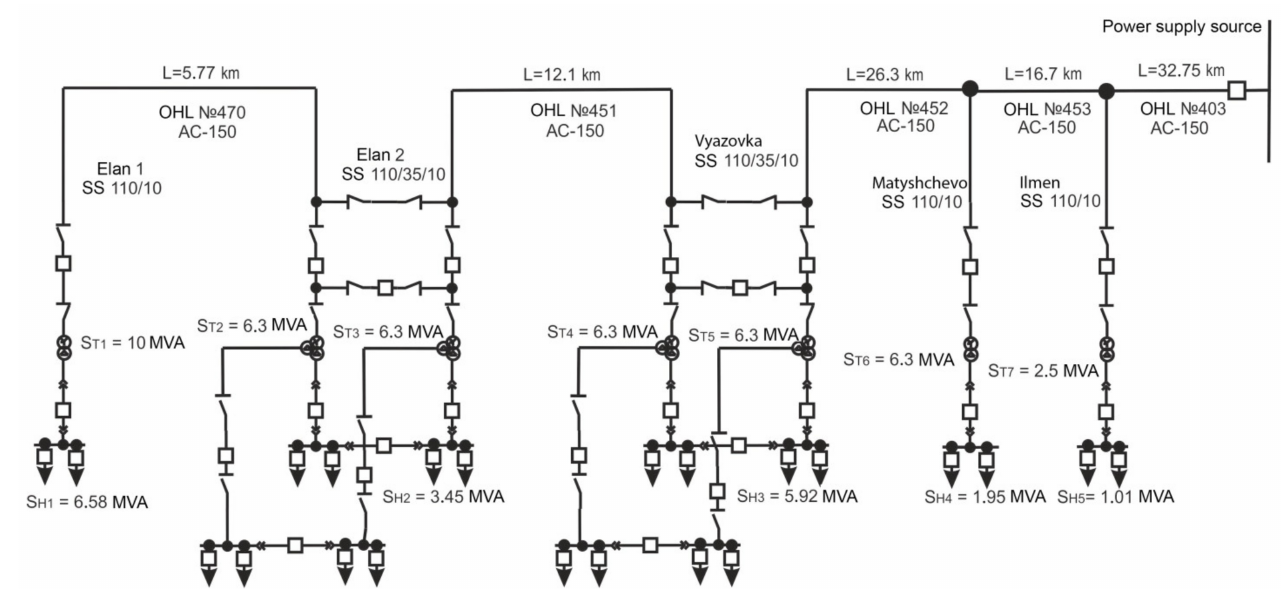
Figure 12. Scheme of a main power transmission line.